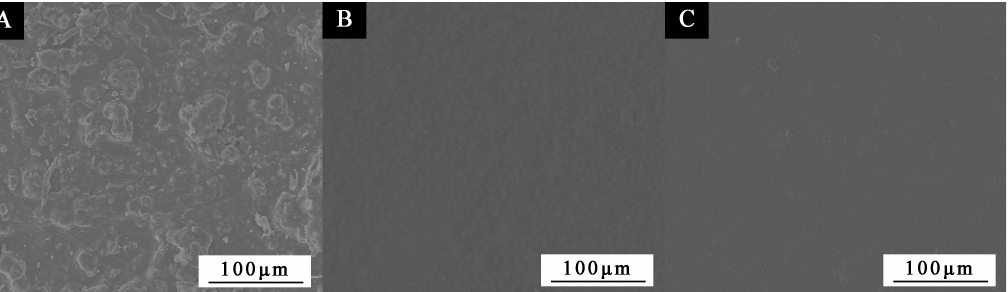
Figure 3. SEM by different coating processes: ( A ) topcoat with thermochromic microcapsules, primer with photochromic microcapsules; ( B ) topcoat with photochromic microcapsules, primer with thermochromic microcapsules; ( C ) mixed microcapsules.